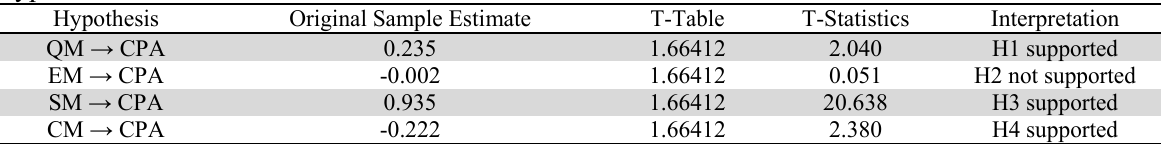
Hypothesis Test Hypothesis